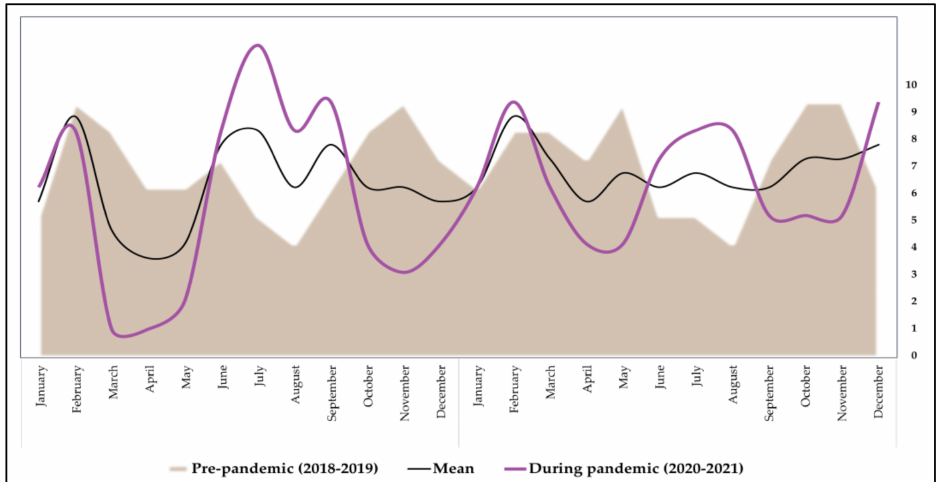
Figure 2. Evolution of malignant melanoma patient addressability before and during the COVID-19 pandemic. X-axis represents a monthly overlay of melanoma cases during the years 2018–2019 and 2020–2021. Y-axis represents the number of patients recorded each